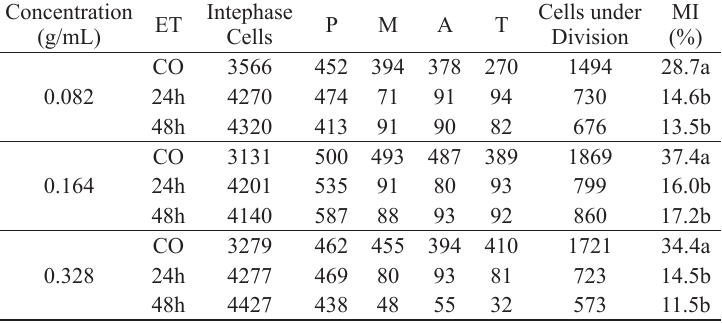
Number of cells in interphase and at different stages of cell division, total cell analyzed in cell cycle root tips of analyzed in cell cycle root tips of A. cepa treated with water (control) and three concentrations rhytidome tea of H. stigonocarpa , 0.082, 0.164, 0.328g/mL under ET of 24 and 48 h. 5,000 cells were analyzed for each control group and